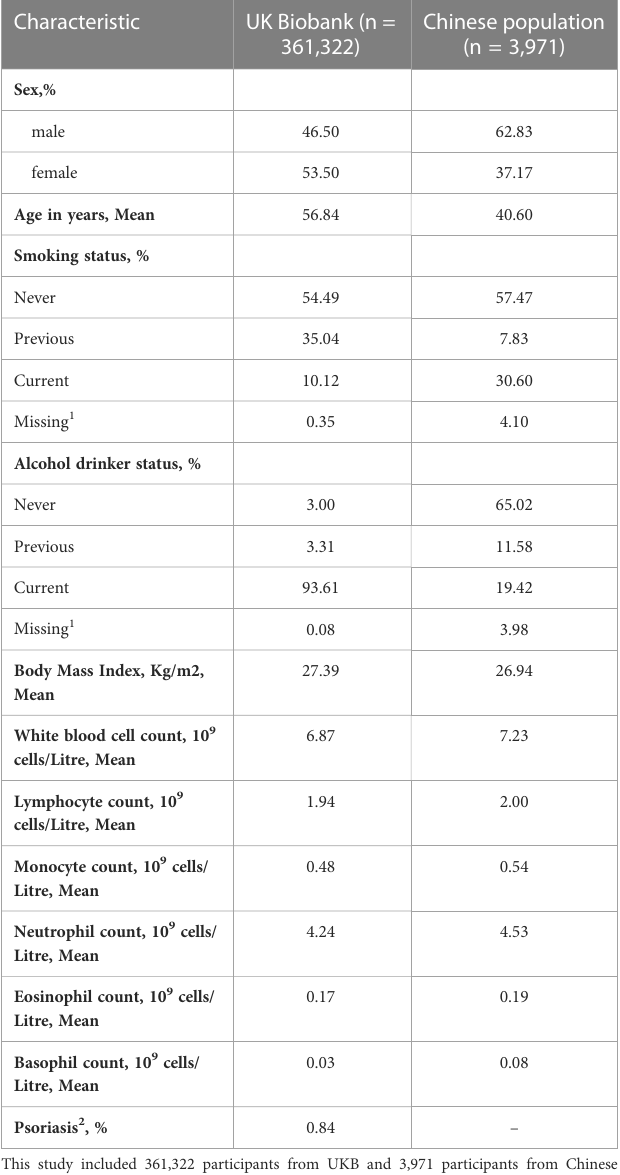
TABLE 1 Characteristics of participants in UKB and Chinese population.